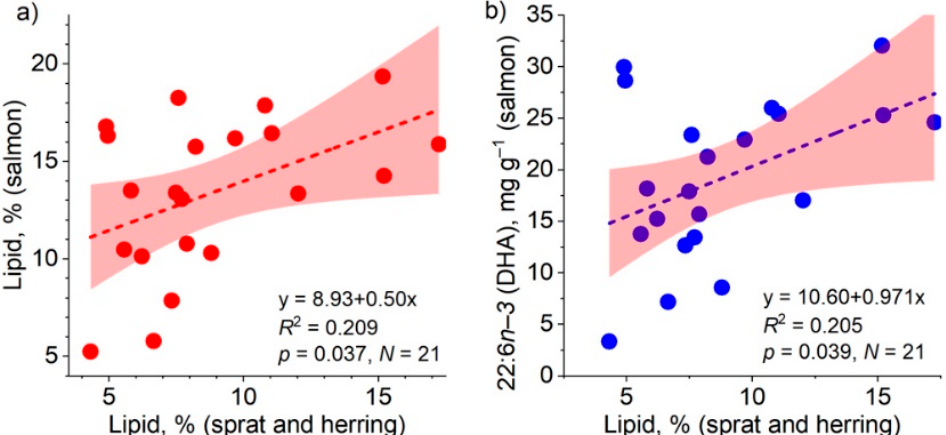
Figure 6. Relationship of the ( a ) lipid content and ( b ) docosahexaenoic acid (22:6 n − 3 , DHA) concentration of salmon ( Salmo salar ) with lipid content of prey fish sprat ( Sprattus sprattus ) and herring ( Clupea harengus ) caught in the fall. Salmon, sprat, and herring were from the Baltic Proper, Bothnian Sea, and Gulf of Finland. The fitting of the linear models with 95% confidence bands, coefficients of determination ( R 2 ), significances ( p ) of the model, and the number of samples are given.